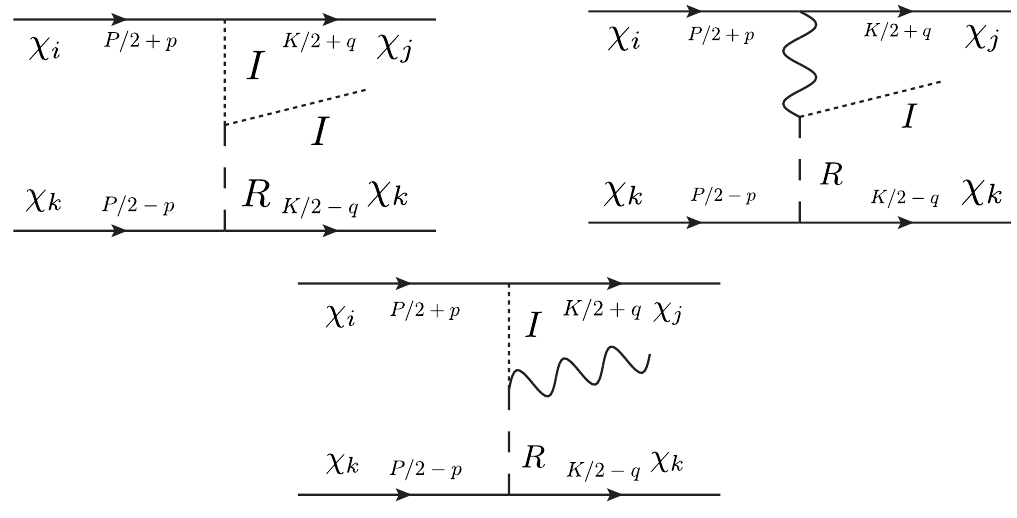
Figure 16 . Derived diagrams of the emission from the